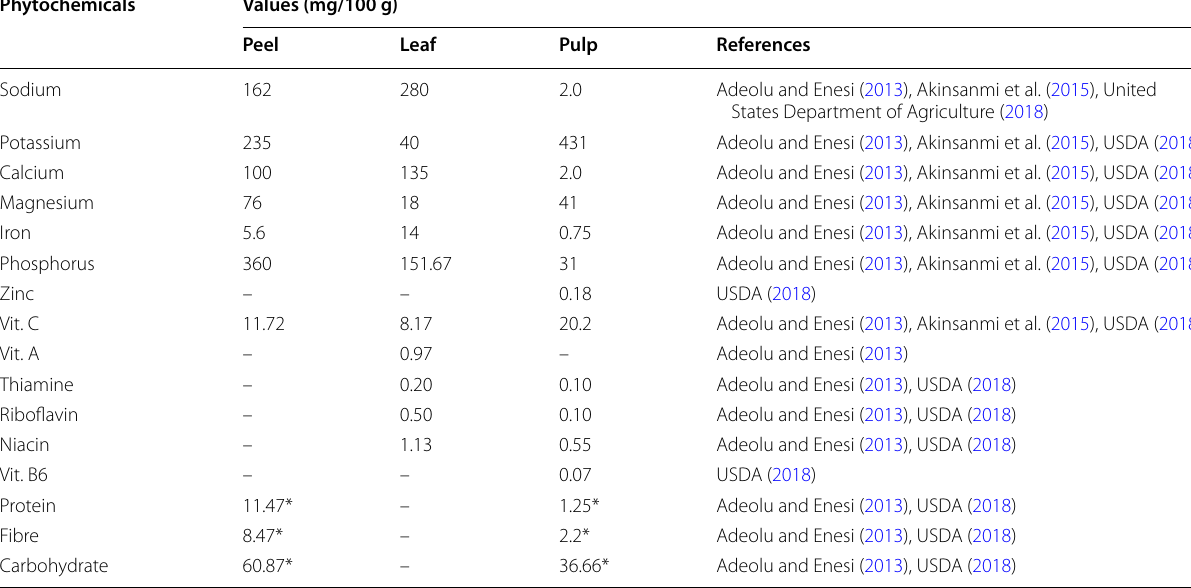
Values with asterisk (*) are in grams (g)